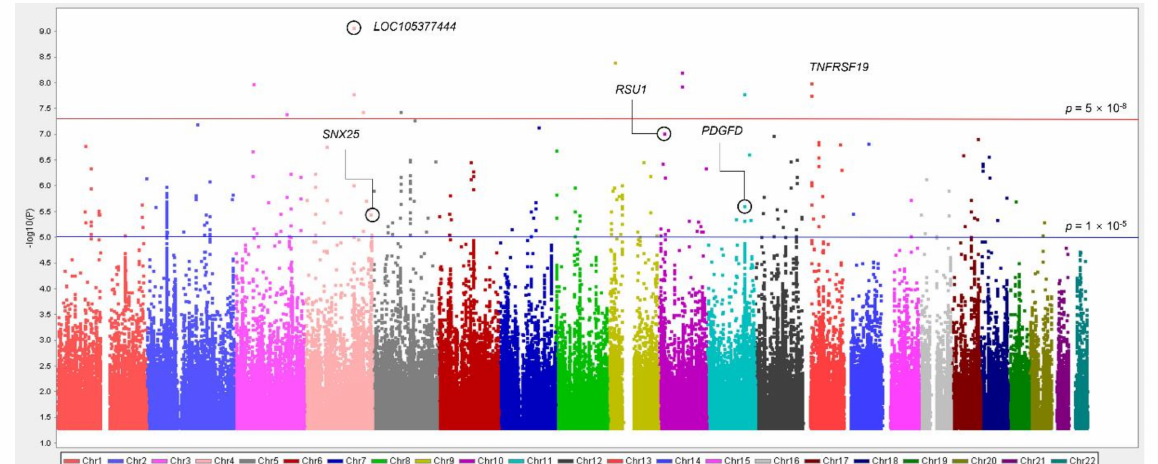
Figure 1. Manhattan plot of results from metabolite GWAS analysis of IDO activity. Red line indicates genome-wide significance threshold at p < 1 × 10 − 8 . Blue line represents significance threshold at p < 1 × 10 − 5 . Vertical axis indicates − log 10 p values from linear regression adjusted for age, area, gender, BMI, drinking, smoking, SBP, hs-CRP, and HbA1c. Horizontal axis shows chromosomal positions. The Manhattan plot was generated with the Haploview